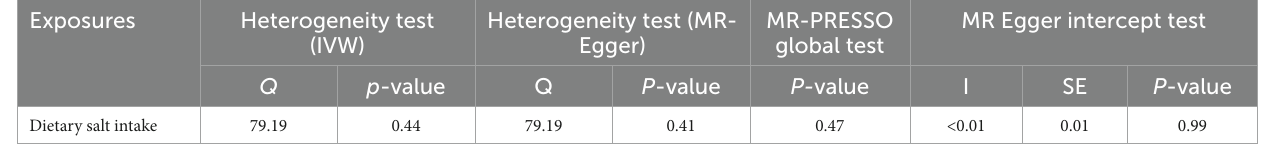
TABLE 2 Heterogeneity and pleiotropy estimates for the associations between dietary salt intake and AF.